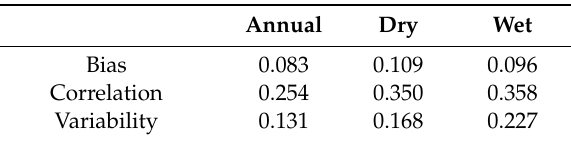
Table 2. Mean median KGE components scores. Bias, Correlation and Variability are expressed as | B − 1 | , | R − 1 | and | V − 1 | , respectively (see Equation